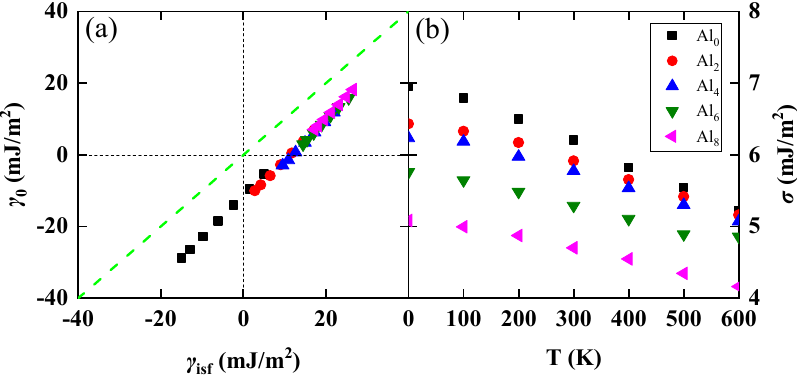
Figure 4. ( a ) Comparison between γ isf and γ 0 (in mJ / m 2 ) of PM fcc Al y (CrMnFeCoNi) 100 − y ( y = 0, 2, 4, 6, 8) alloys. Symbols correspond to temperatures between 0 and 600 K (from left to right) with increments of 100 K. ( b ) The interfacial energy σ (in mJ / m 2 ) is plotted as a function of temperature and composition.